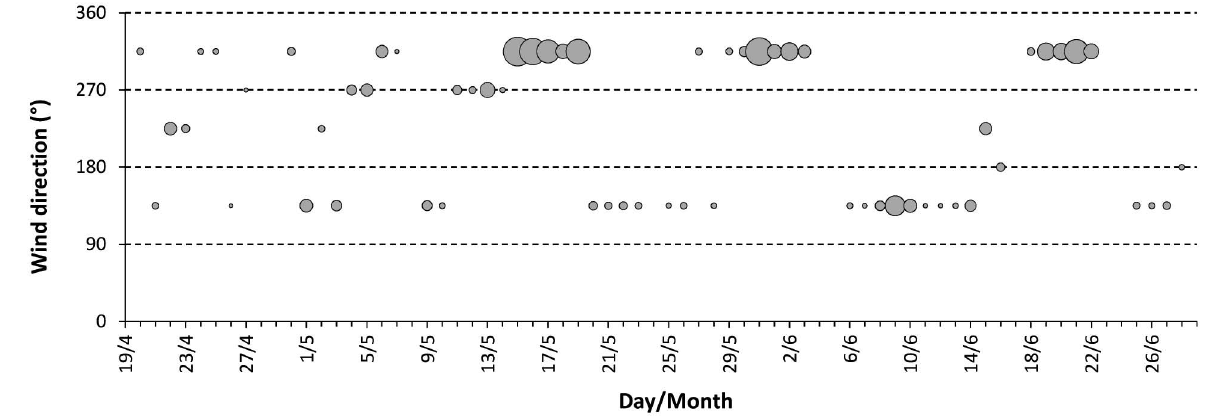
Fig. 4. – Bubble plot representing the wind statistics by quadrant during 2010. The dimension of bubbles is related to the wind intensity. The plot highlights three significant strong Mistral events (wind classes between 270° and 360°) used for the short-term